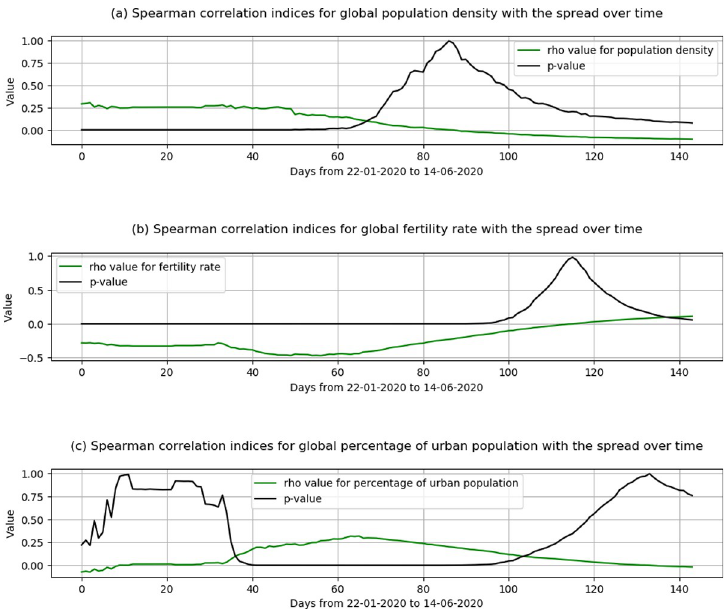
Fig 5. Spearman correlation indices for the select urban features with the coronavirus spread (the period between 22/01/2020 to 14/06/2020).